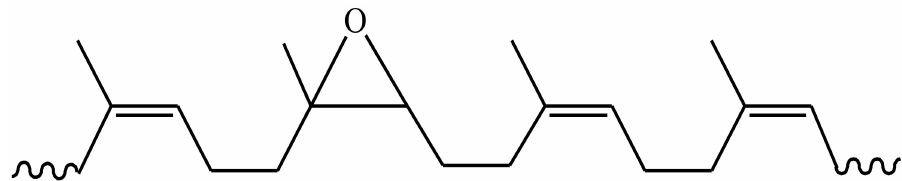
Figure 1. Chemical structure of epoxidized natural rubber